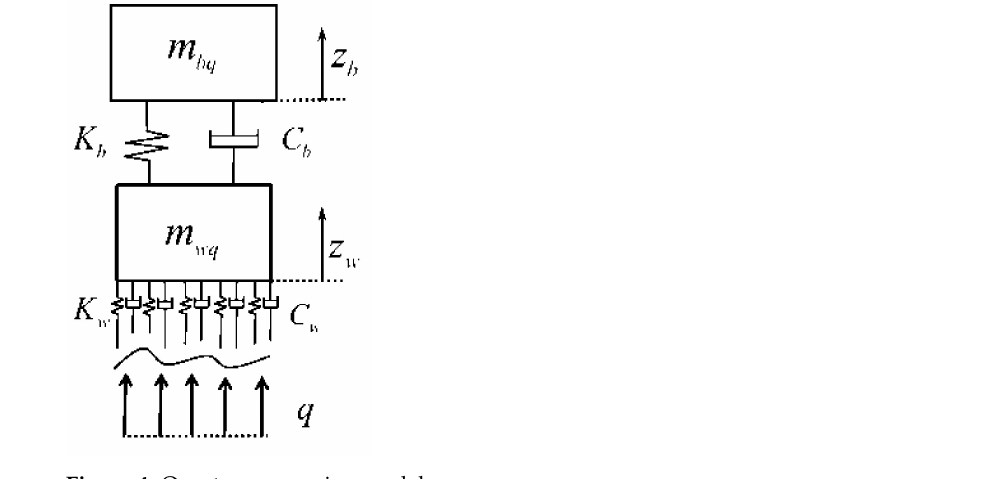
Figure 4. Quarter suspension